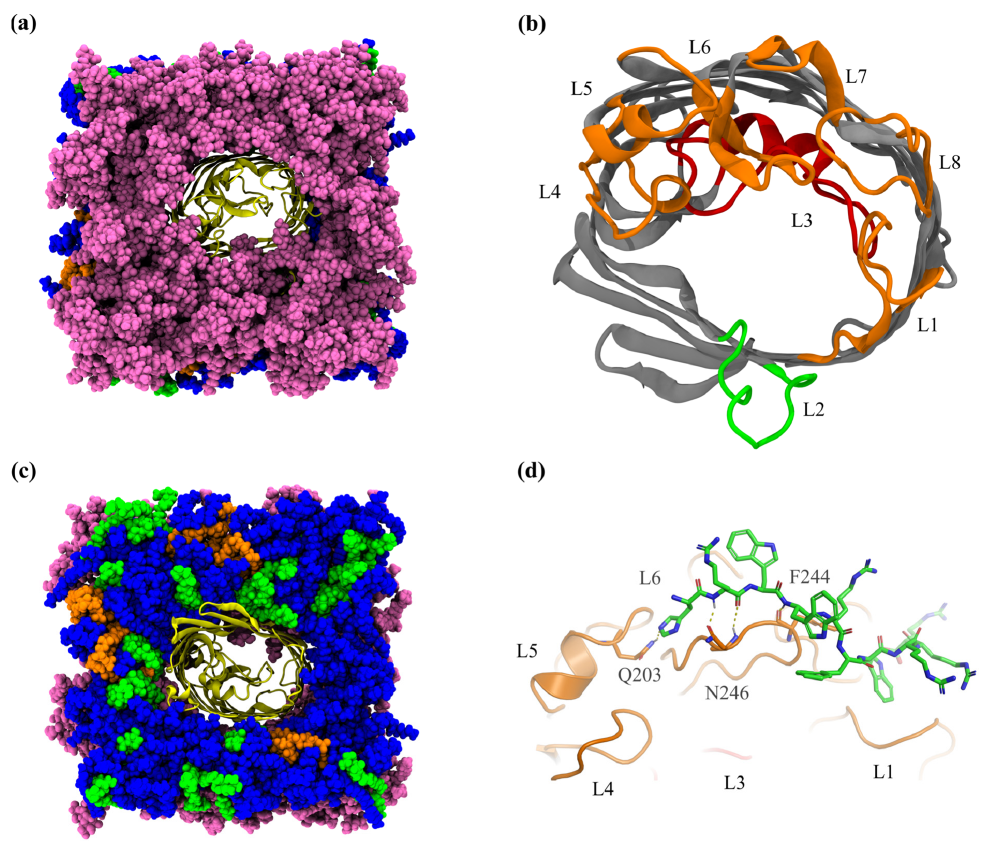
Figure 3. Graphical representation of OmpF inserted in the E. coli OM composed of R-LPS: ( a ) top view of extracellular side and ( c ) periplasmic side (OmpF is colored in yellow, LPS in mauve, PPPE in blue, PVPG in green, PVCL2 in orange). ( b ) Location of OmpF key loops and ( d ) the interaction of P6m peptide (stick representation) with L5 and L6 loops of